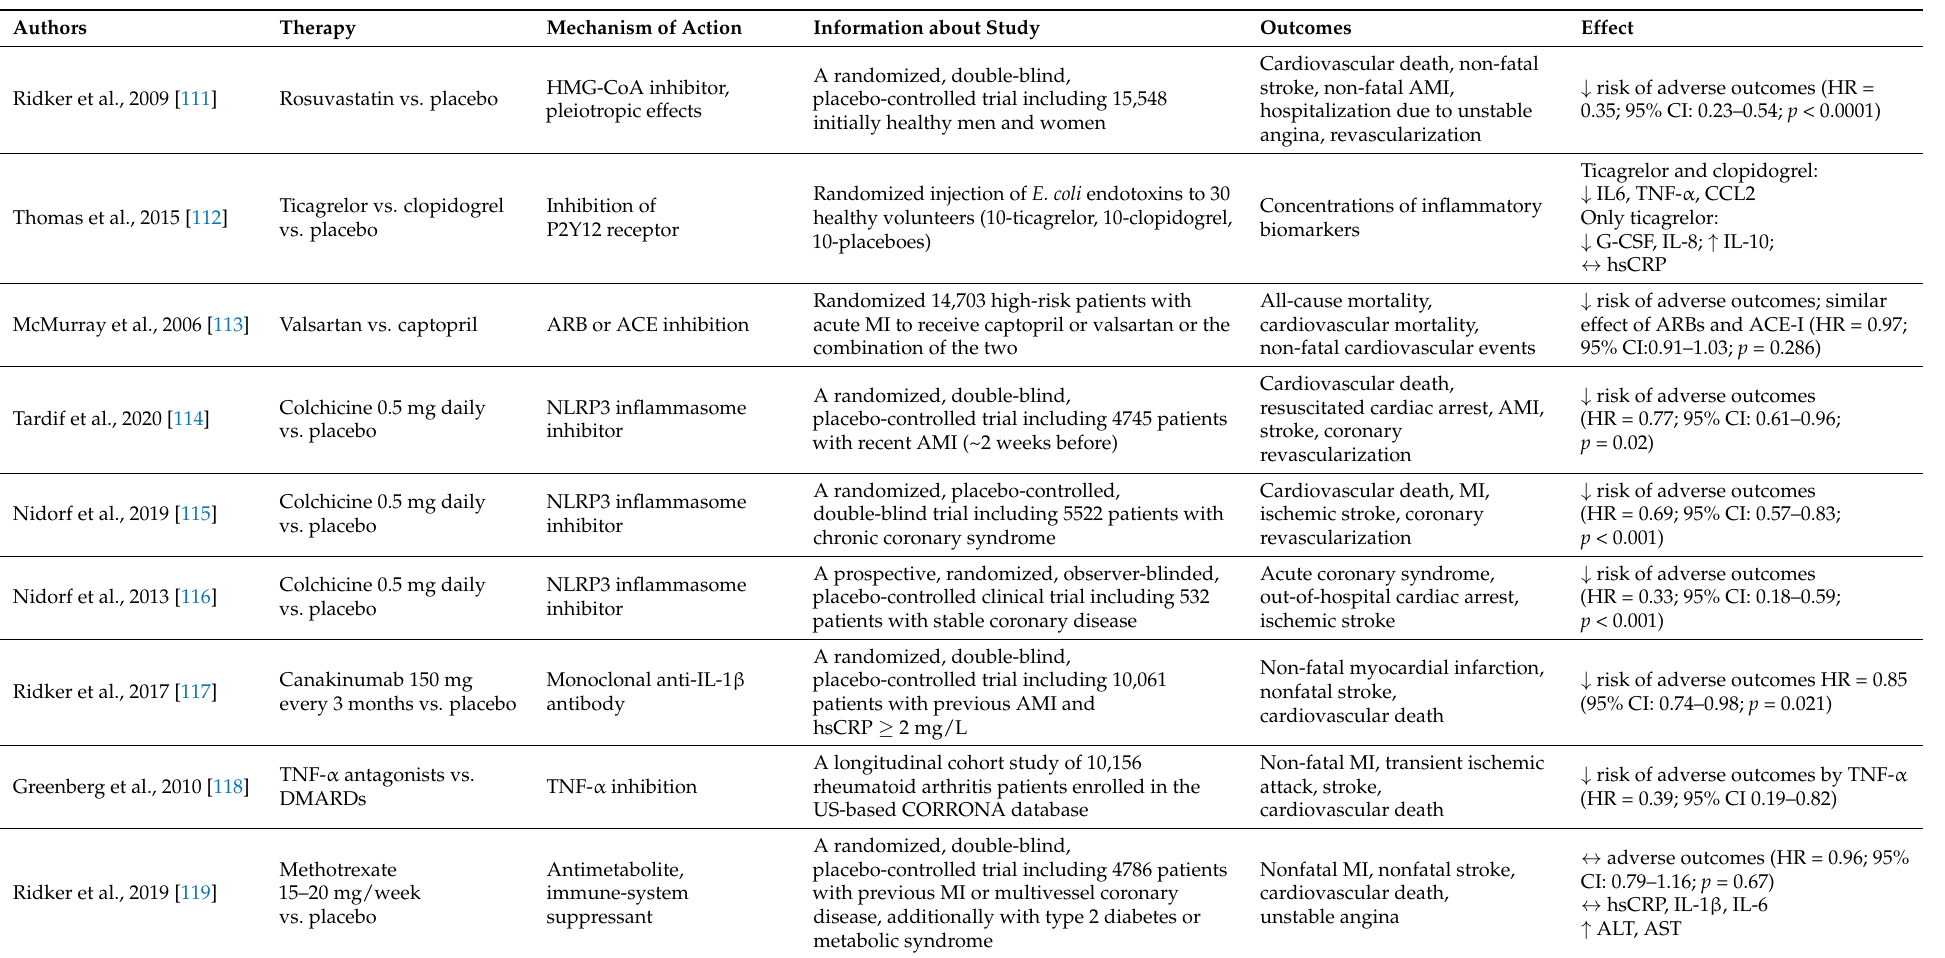
Table 1. Summary of clinical studies evaluating the cardiovascular outcomes in patients receiving anti-inflammatory